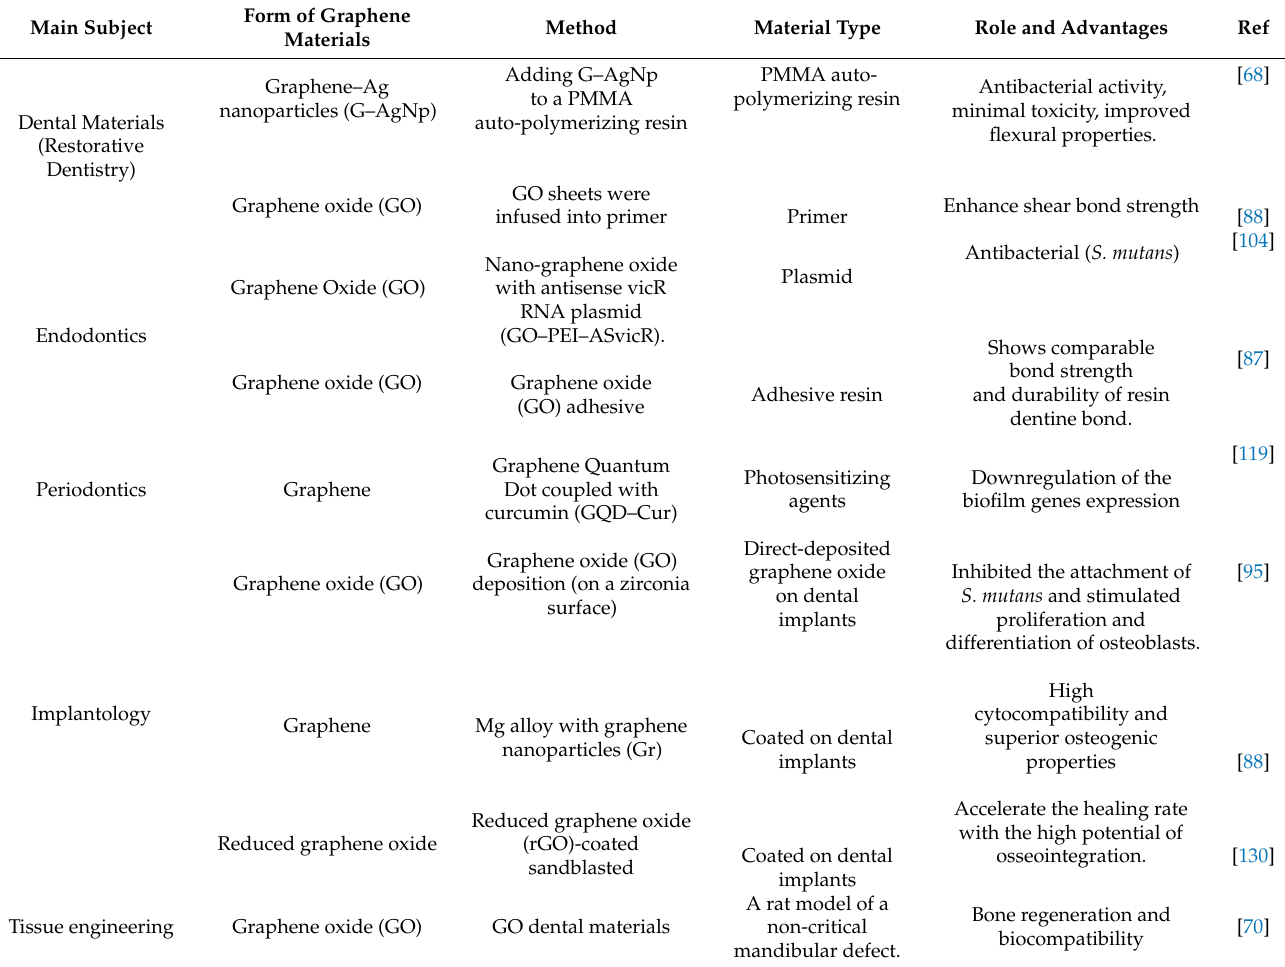
Table 1. Summary of graphene and its derivatives in